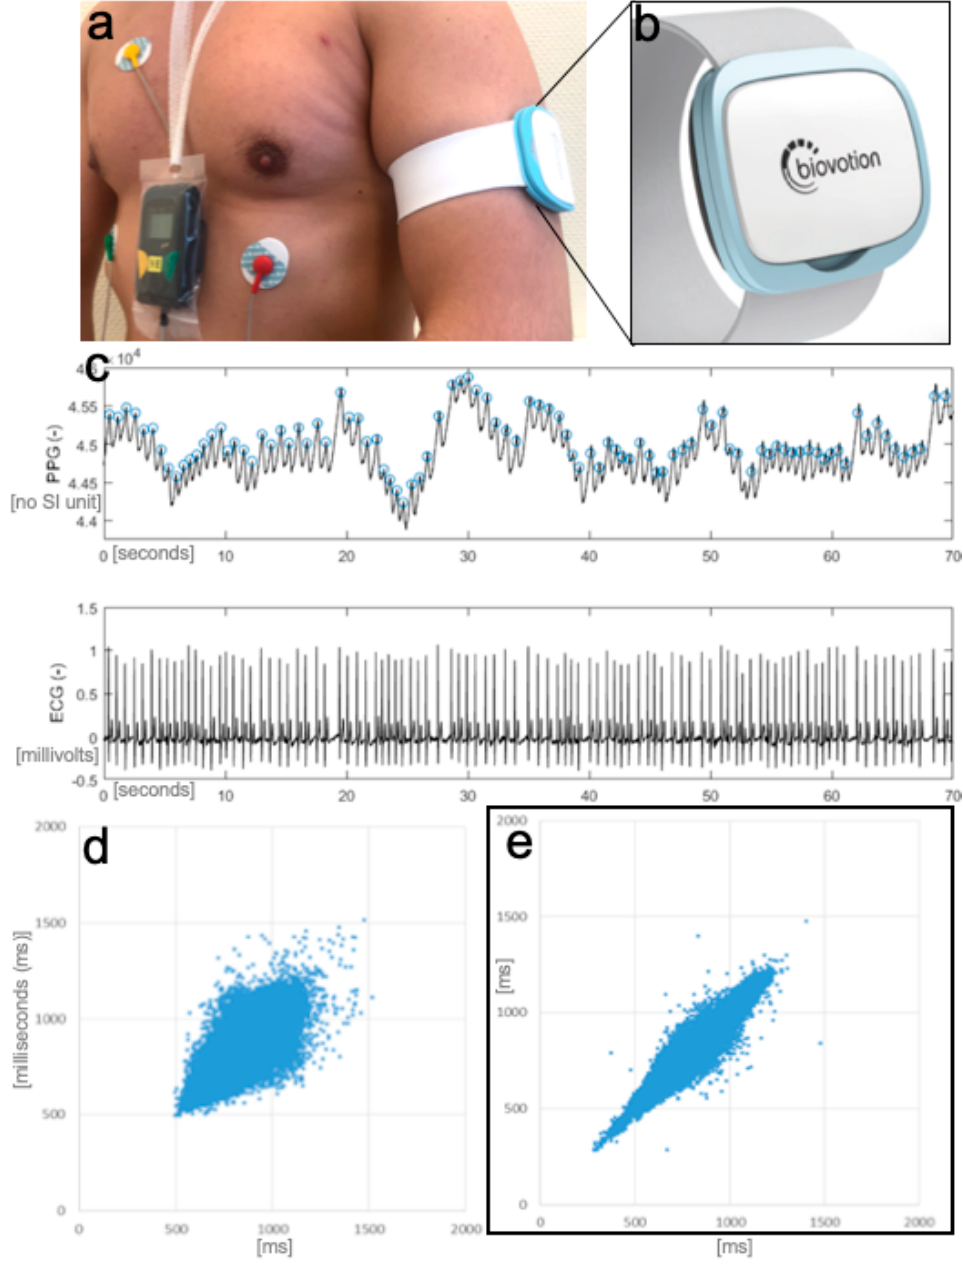
Figure 2. Recordings setup with the medical wearable attached to the left upper arm and ECG Holter ( a ); wearable ( b ); recorded signals ( c ) (first-row photoplethysmography (PPG), second-row ECG; showing an atrial fibrillation (AF) recording); Poincaré plot of PPG derived inter-beat intervals in AF ( d ) and sinus rhythm ( e ).